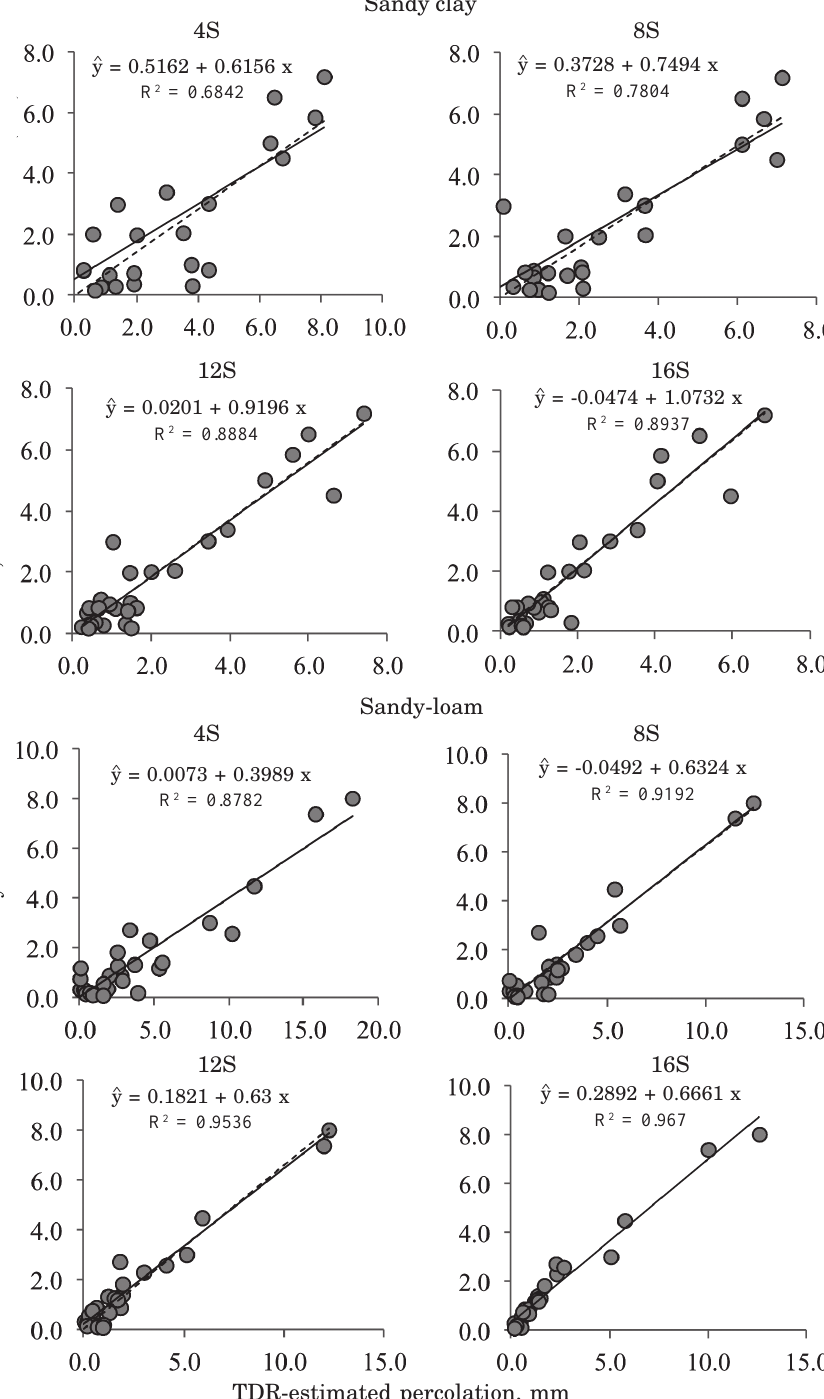
Figure 4. TDR-estimated and lysimeter-measured percolation